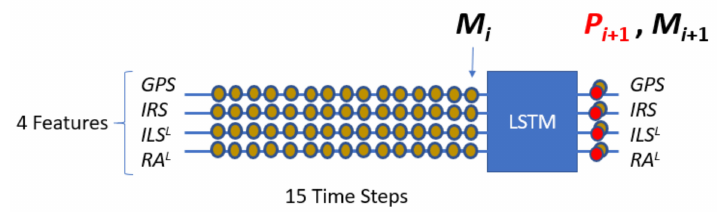
Figure 12. PM Z (real values).